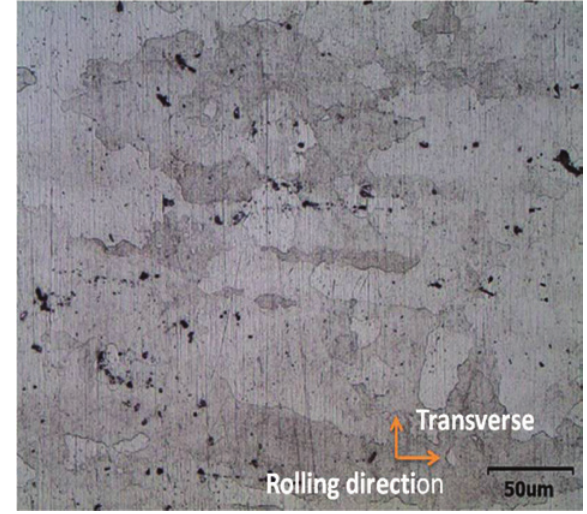
Figure 4: Optical micrograph of AA7075-T651.